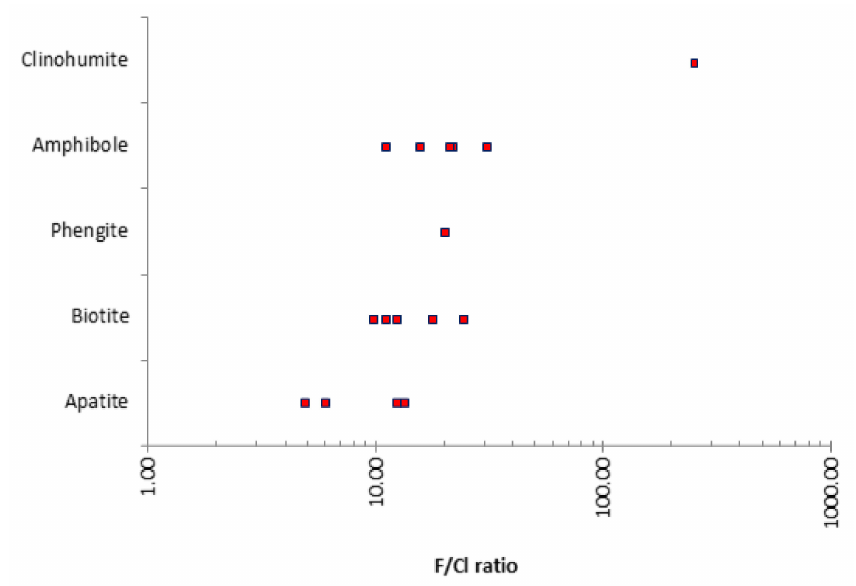
Figure 6. Comparison of the F/Cl ratios of eclogitic hydrous minerals. Apatites from samples QC26C, QC26E, QC26H and QC36U are predominantly of the fluorapatite variety (Table 3), with up to 2.8 wt% F (0.77 F atomic formula units, a.f.u.) and <0.5 wt% Cl (0.06 Cl a.f.u.). The F/Cl ratios of apatite samples ranges from 5 to 13, with an average value of 9.